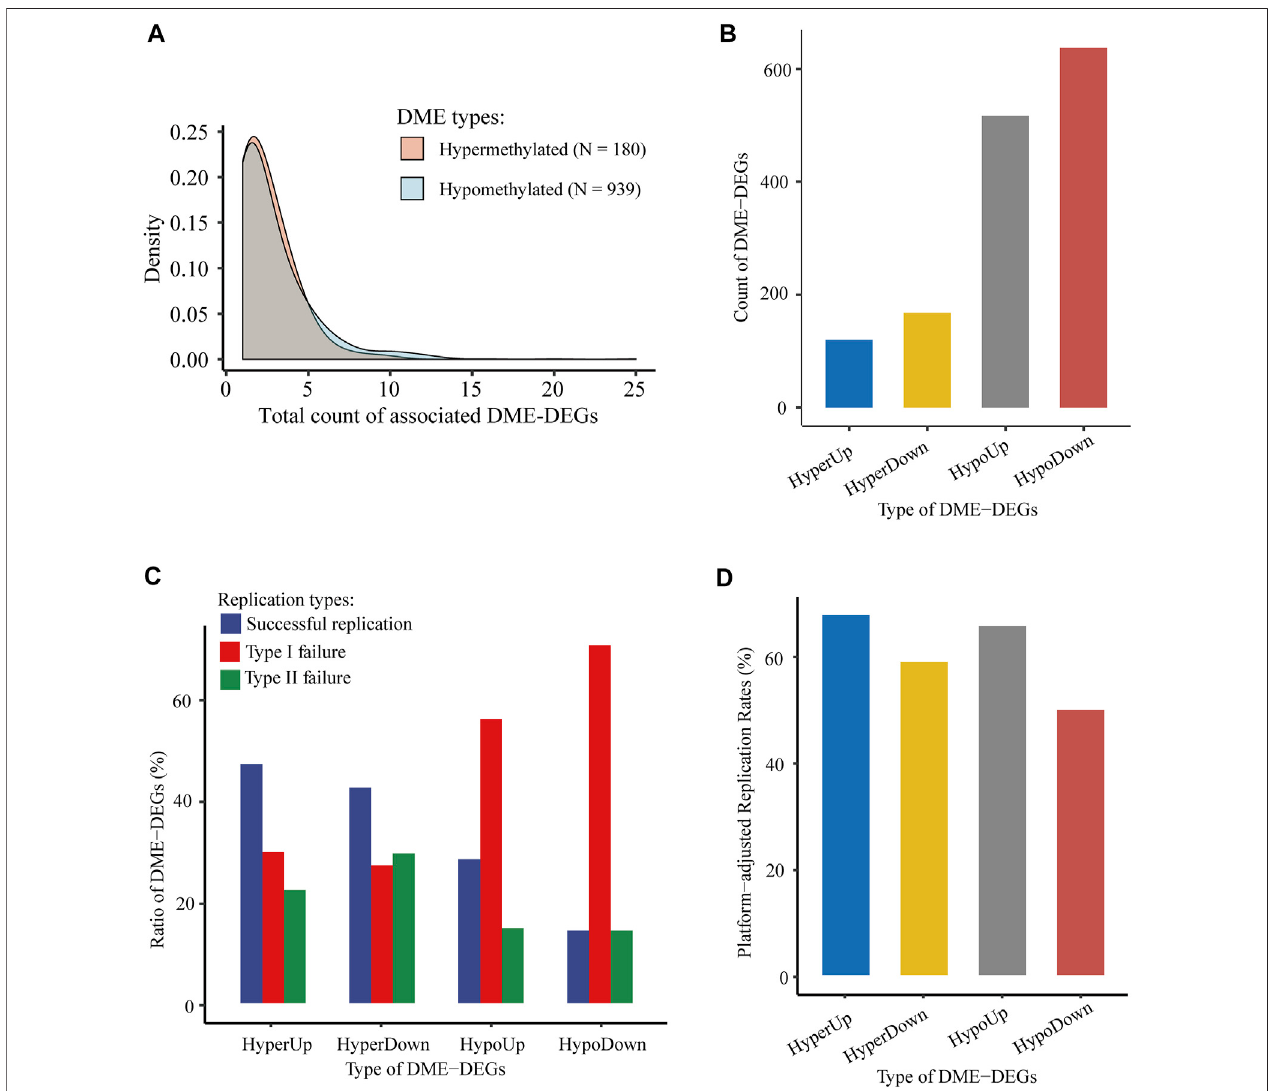
FIGURE 5 | Identi fi cation and validation of genic DMEs and associated DME-DEGs in HCC. (A) Distribution density of the number of associated DME-DEGs of hypermethylated and hypomethylated genic DME. (B) Count of four types ofgenic DME-DEGs. “ HyperUp ” refers tohypermethylated enhancer-associated upregulated DME-DEGs; “ HyperDown ” refers to hypomethylated enhancer-associated downregulated DME-DEGs; “ HypoUp ” refers to hypermethylated enhancer-associated upregulated DME-DEGs, and “ HypoDown ” refers to hypomethylated enhancer-associated downregulated DME-DEGs. (C) Distribution of the three types of replication results of genic DME-DEGs. “ Successful replication ” refers to the successful replication of genic DME-DEGs for correlated differential methylation and differential expression in TCGA-LIHC; “ type I failure ” refers to replication failure due to lack of CpG for the corresponding genic DMEs in TCGA-LIHC; and “ type II failure ” refers to replication failures except type I failure. (D) Platform-adjusted replication rates of four types of genic DME-DEGs in TCGA-LIHC. Platform-adjusted replication rates were calculated as (Count Successful Replication + Count Successful Replication + Count Type I Failure ) * 100%.